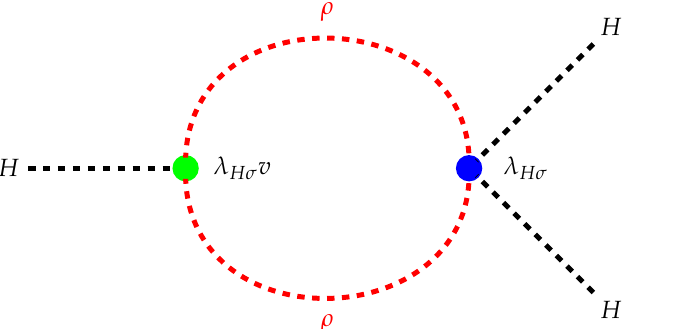
Figure 3. One-loop SM triple Higgs coupling correction diagram with a cubic vertex and a quartic